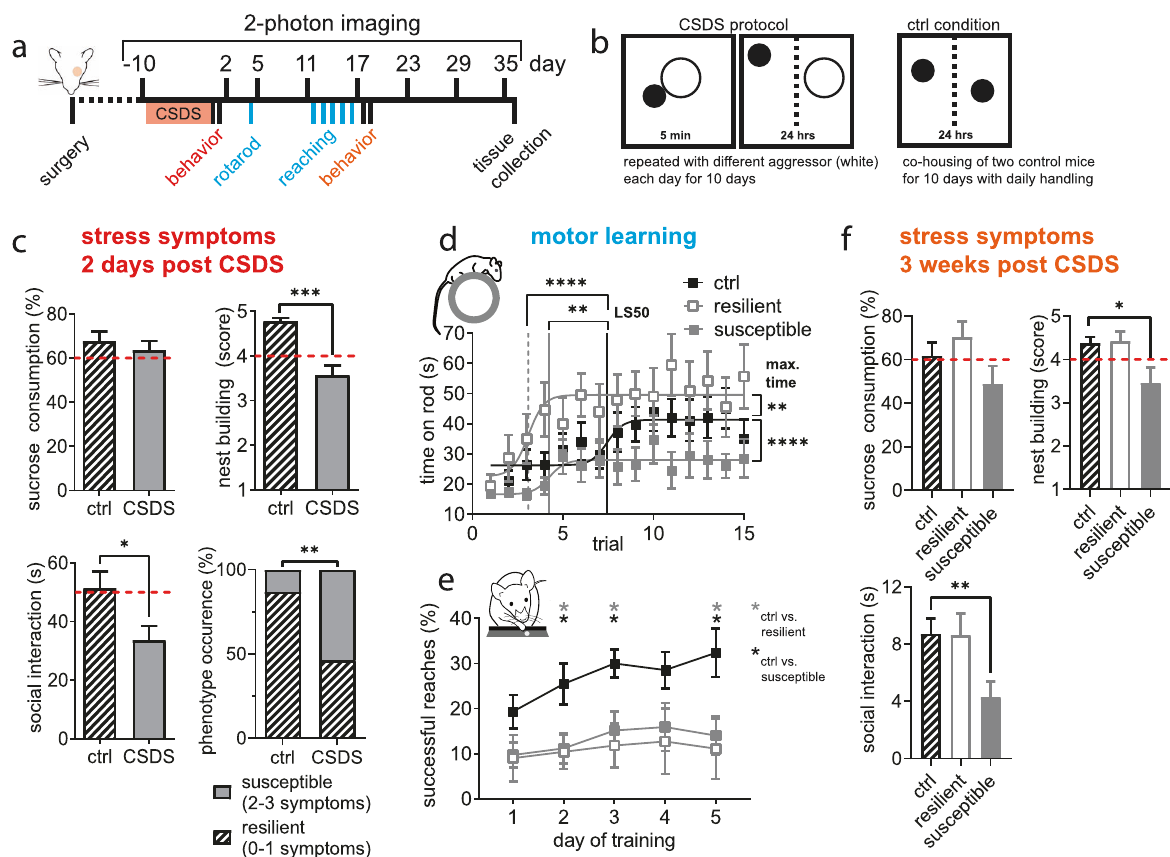
Fig. 1 CSDS phenotypes de fi ned by symptom load have distinct alterations in motor learning. a Experimental timeline (day 0 de fi ned by the last day of CSDS = fi rst day of behavioral testing). b Schematic depiction of the CSDS paradigm and control conditions. c Behavioral testing showed reduced nest building (U = 95, P < 0.0001, Mann-Whitney U test) and social interaction (t 47 = 2.399, P = 0.021, student ’ s t -test) but no change in sucrose consumption (U = 264, P = 0.493, Mann-Whitney U test) in the CSDS group. Individual test results (red dashed lines: cutoff as described in methods) were used for classi fi cation as resilient or susceptible phenotype based on symptom load with increased occurrence of the susceptible type after CSDS ( P = 0.033, Fisher ’ s exact test); ctrl n = 23, CSDS n = 26 mice. d Susceptible mice failed whereas resilient mice excelled on the accelerating rotarod compared to controls (maximum time: F 2,687 = 22.03, P < 0.0001; learning speed [LS50]: F 2,687 = 10.08, P < 0.0001; one-way ANOVA with Dunett ’ s post-hoc test). Performance during the fi rst trial did not differ between the three groups (F 2,687 = 1.574, P = 0.208; one-way ANOVA); ctrl n = 20, resilient n = 12, susceptible n = 14 mice. e Learning the fi ne motor task of skilled forelimb reaching over 5 days was impaired in stressed mice (time F 2.209,70.70 = 3.606, P = 0.028; stress F 2,32 = 5.211, P = 0.011; interaction F 8,128 = 0.762, P = 0.637, RM ANOVA with Dunett ’ s post-hoc test); ctrl n = 15, resilient n = 7, susceptible n = 9 mice (group size reduced by task speci fi c exclusions, see methods for details). f Susceptible and resilient stress phenotypes were persistent ~3 weeks after CSDS with only susceptible mice versus controls showing reduced social interaction (H 2 = 10.22, P = 0.006, Kruskal-Wallis test with Dunn ’ s post-hoc test) and nest building (F 2,43 = 4.852, P = 0.013, one-way ANOVA with Dunett ’ s post-hoc test). Sucrose consumption did not signi fi cantly differ between stressed and control mice as observed before (H 2 = 3.844, P = 0.146, Kruskal-Wallis test); ctrl n = 20, resilient n = 12, susceptible n = 14 mice. * P < 0.05, ** P < 0.01, *** P < 0.001, **** P < 0.0001. Results are shown as mean ±